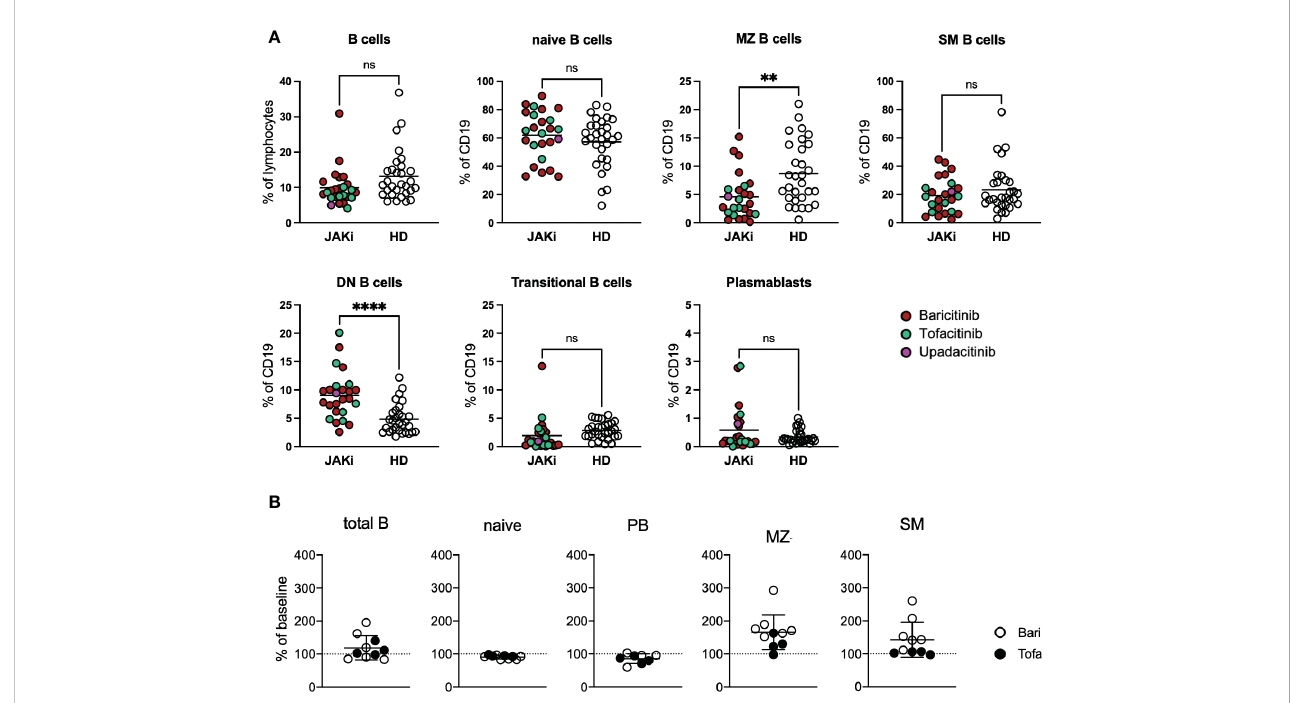
FIGURE 1 B cell phenotyping of RA patients under JAK inhibitor treatment. (A) PBMCs from 25 RA patients under JAK inhibitor treatment (16 baricitinib, 8 tofacitinib, 1 upadacitinib) as well as 30 healthy donors were stained with fl uorochrome-labelled antibodies to assess expression of surface markers by spectral fl ow cytometry (Cytek Aurora). Gating strategy depicted in Supplementary Figure 1A. Statistical analysis by t-test, **p < 0.005, 0.0005, ****p < 0.0001; ns, not signi fi cant. (B) B-cell subpopulations of 10 RA patients before and under JAK inhibitor therapy. Data depicted as percent of baseline. PB, plasmablasts; MZ-like, marginal zone-like B cells; SM, switched memory B cells; Bari, baricitinib; Tofa,